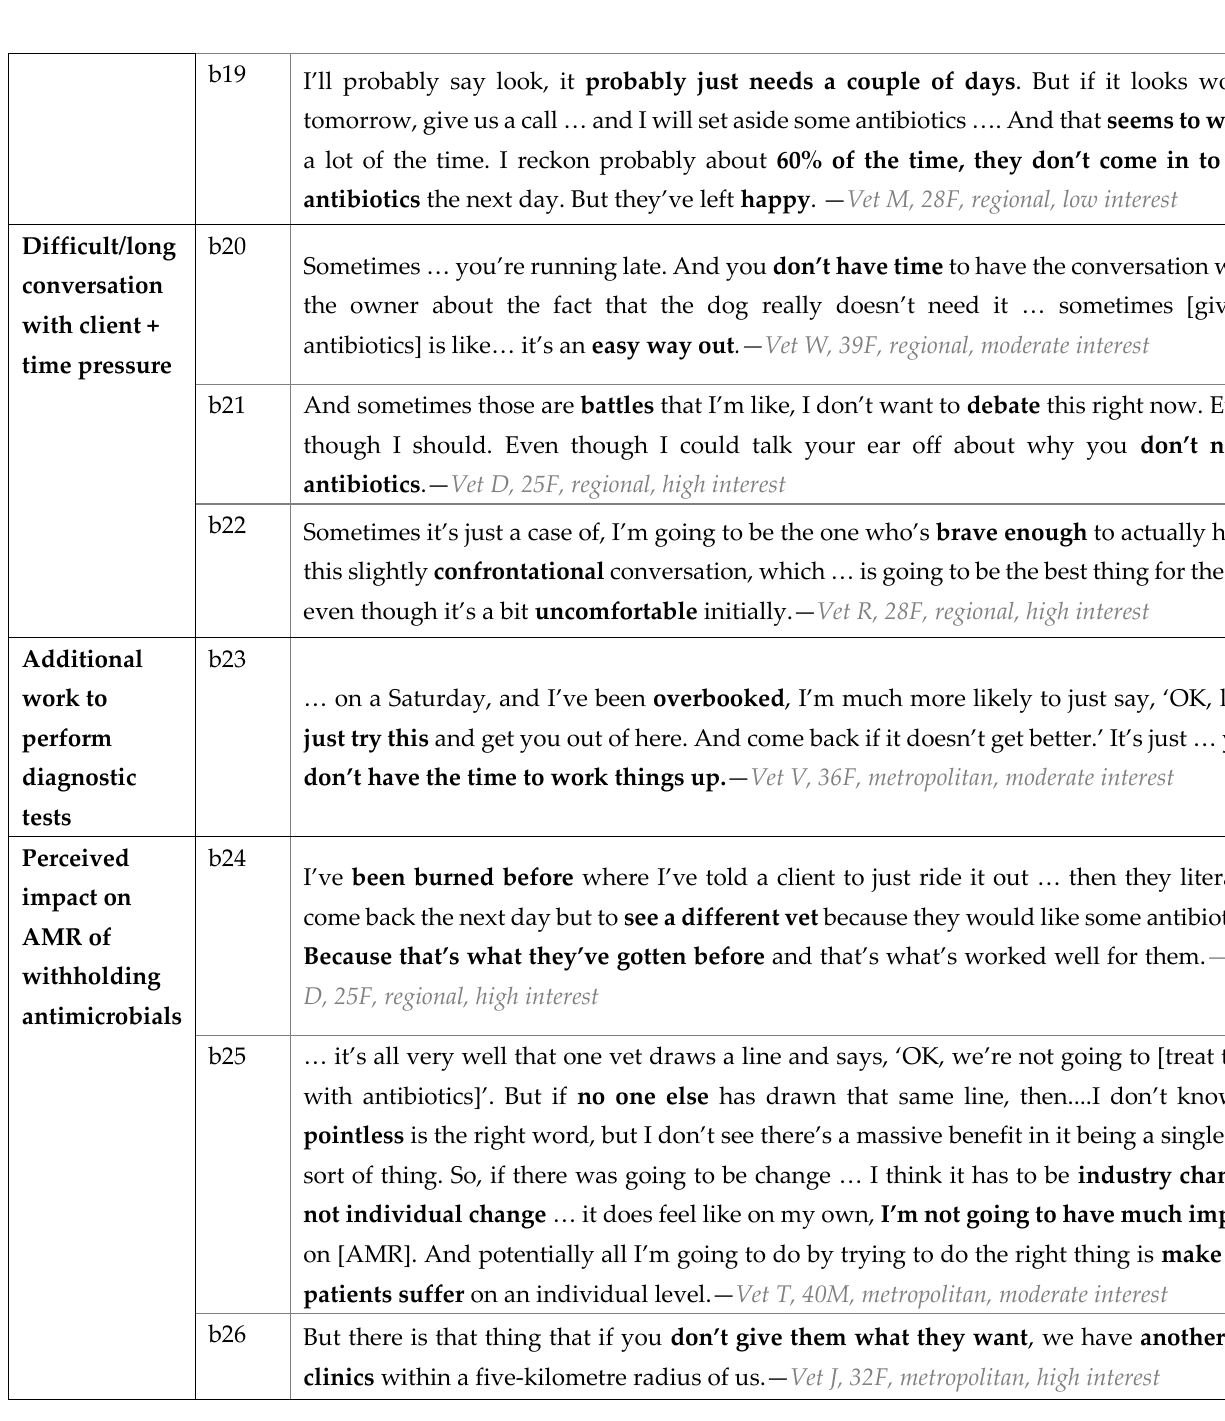
Figure 4. Background factors influencing the decision to withhold or delay antimicrobial treatment where there was no clear indication, and illustrative quotes. Bold text has been used to highlight key ideas. Grey italics have been used for participant code, age and gender, location of practice and level of interest in AMR and AMS. There were three main scenarios in which participants described giving systemic antimicrobials when they were not indicated. The first is where the cause of illness was probably or certainly not responsive to antimicrobials, but the client expected the veterinarian to medicate the animal, sometimes specifically with an antimicrobial (b1, b7, b11, b12, b13, b15, a29). Alternatively, it could be where the client was frustrated (a27) or despondent about their animal’s condition, such as the client ‘at their wit’s end’ dealing with a dog with diarrhoea (a28), increasing the pressure for the veterinarian to take action to address the problem.